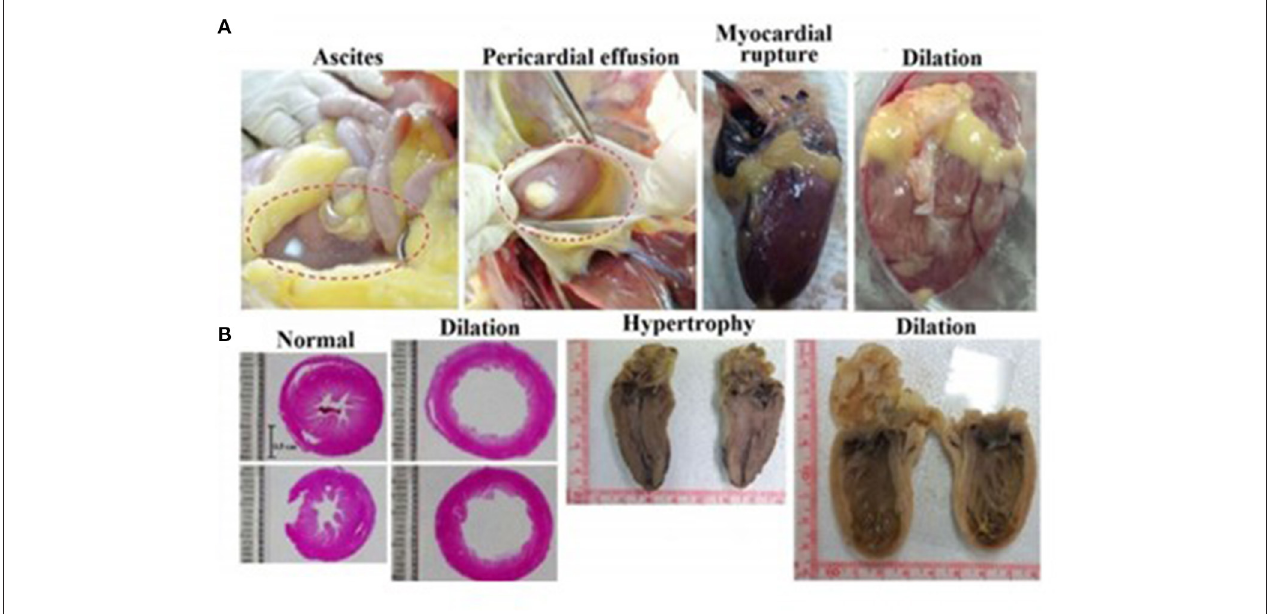
FIGURE 2 | Obesity-associated cardiac disorders in adult broiler chickens. Broiler chickens 49 weeks or older fed ad libitum for 70 days developed significantly more cardiac lesions than calorie restricted birds. (A) Diet-induced alterations in cardiac gross morphology in the form of ascites (fluid accumulation), pericardial effusion, myocardial rupture, and cardiac dilation (B) Internal compensatory responses lead to myocardial dilation or hypertrophy as evident in hens experiencing sudden death. Not shown is the many-fold increase in collagen content in the cardiac tissue in the ad libitum vs. restricted diet population evident in both surviving birds and those experiencing sudden death. Ad libitum birds additionally showed a significantly higher incidence of arrhythmia as well as chronic elevation of systolic blood pressure (from Chen et al., 2017).